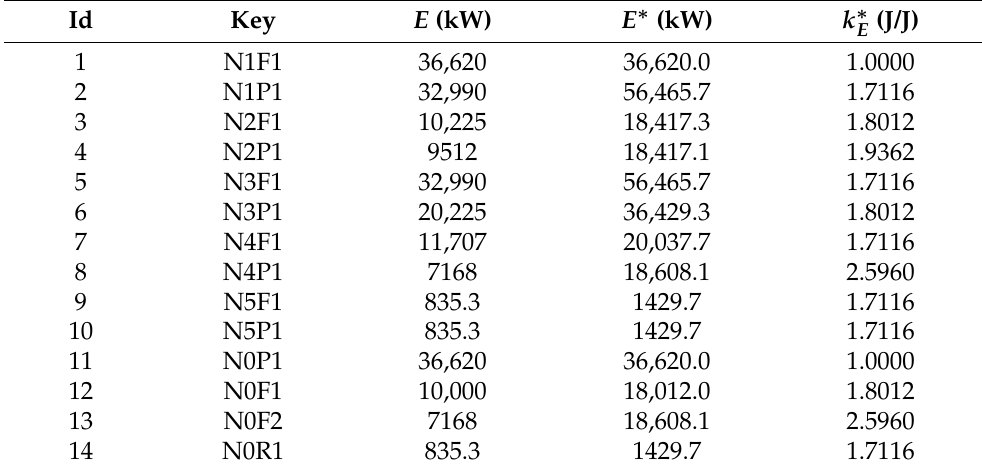
Table 3. Productive streams exergy costs for TGAS example.